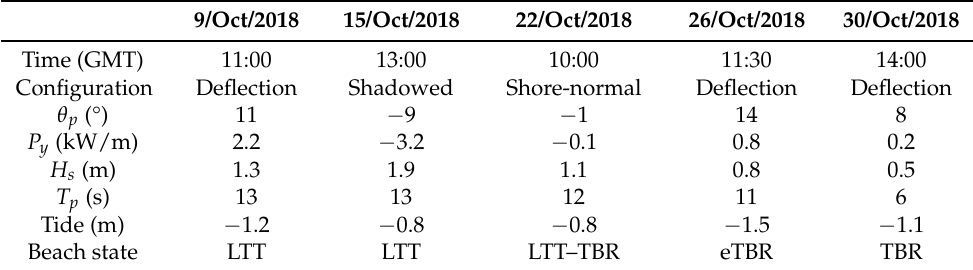
Table 3. Field conditions for Figure